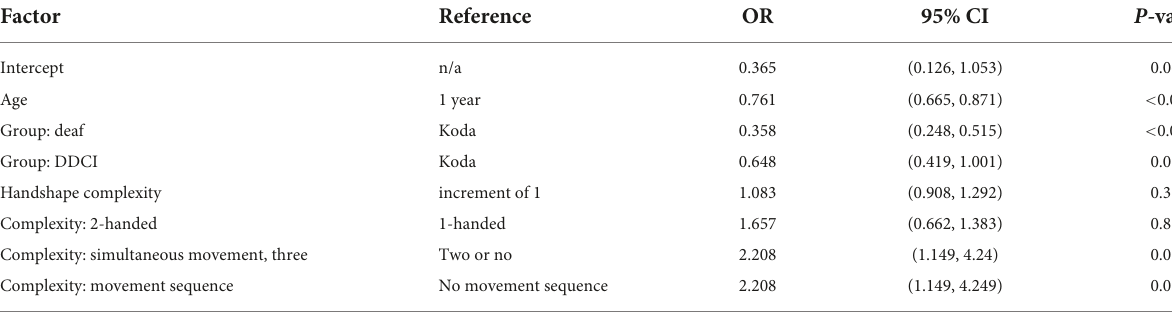
TABLE 4 Results of multivariate logistic regression of overall accuracy of the item on age, group, and complexity. Factor